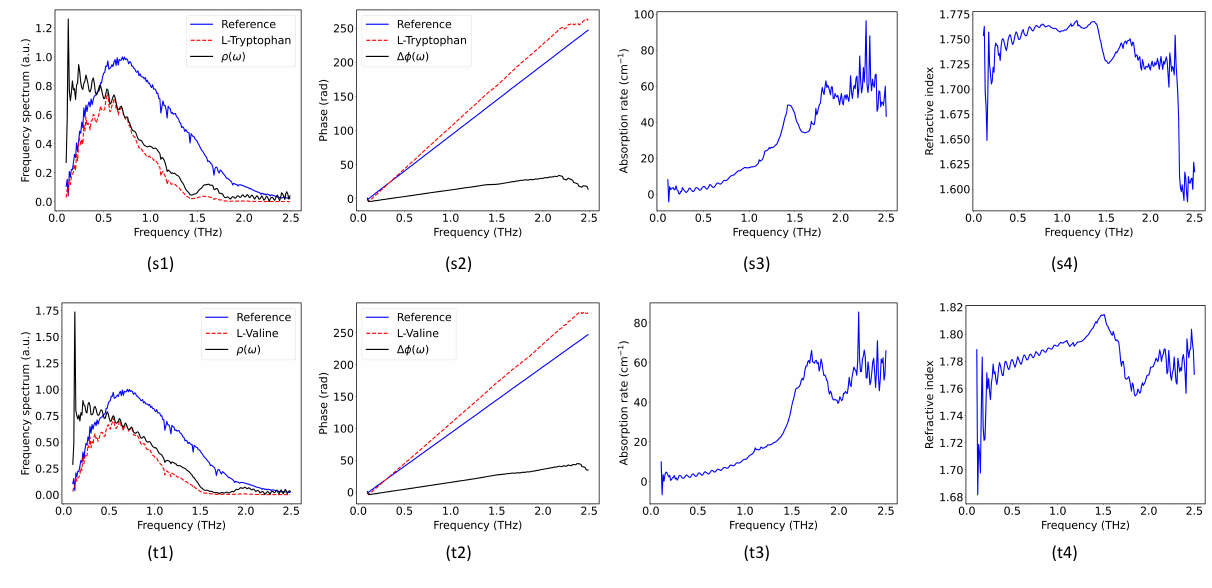
Figure A1. ( a – t ) are Beta-Alanine, D-Alanine, L-Alanine, D-Arginine, L-Arginine, D-Aspatic acid, L-Aspatic acid, D-Glutamic acid, L-Glutamic acid, D-Serine, L-Serine, DL-Tyrosine, L-Tyrosine, Glycine, L-Leucine, L-Lysine, L-Methionine, L-Threonine, L-Tryptophan, and L-Valine, respectively. In each group, 1 and 2 are the amplitude and phase of the frequency–domain spectrum; 3 and 4 are the absorption rate and the refractive index of the